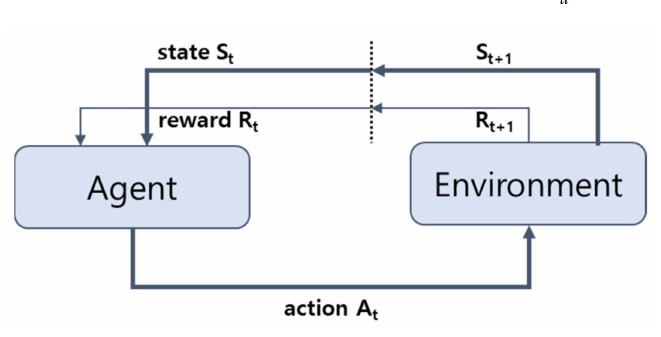
Figure 3. Q-learning